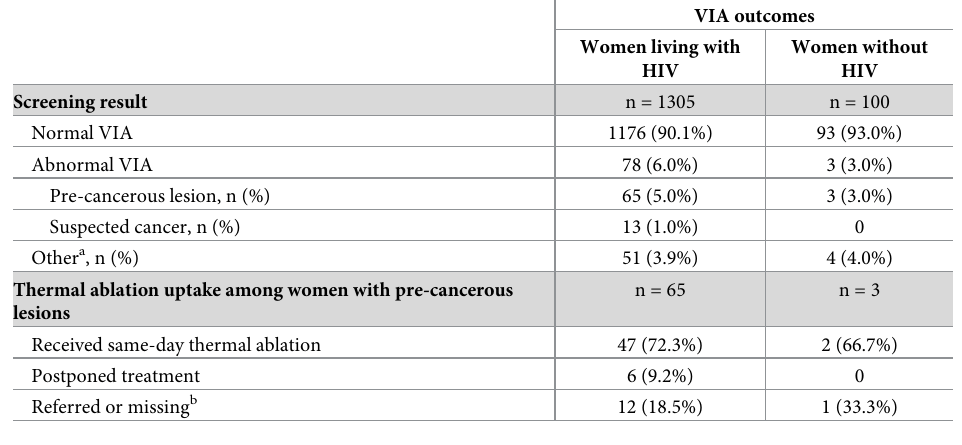
than women without HIV in this sample, in unadjusted (OR 1.70, 95% CI: 0.52, 5.49) or